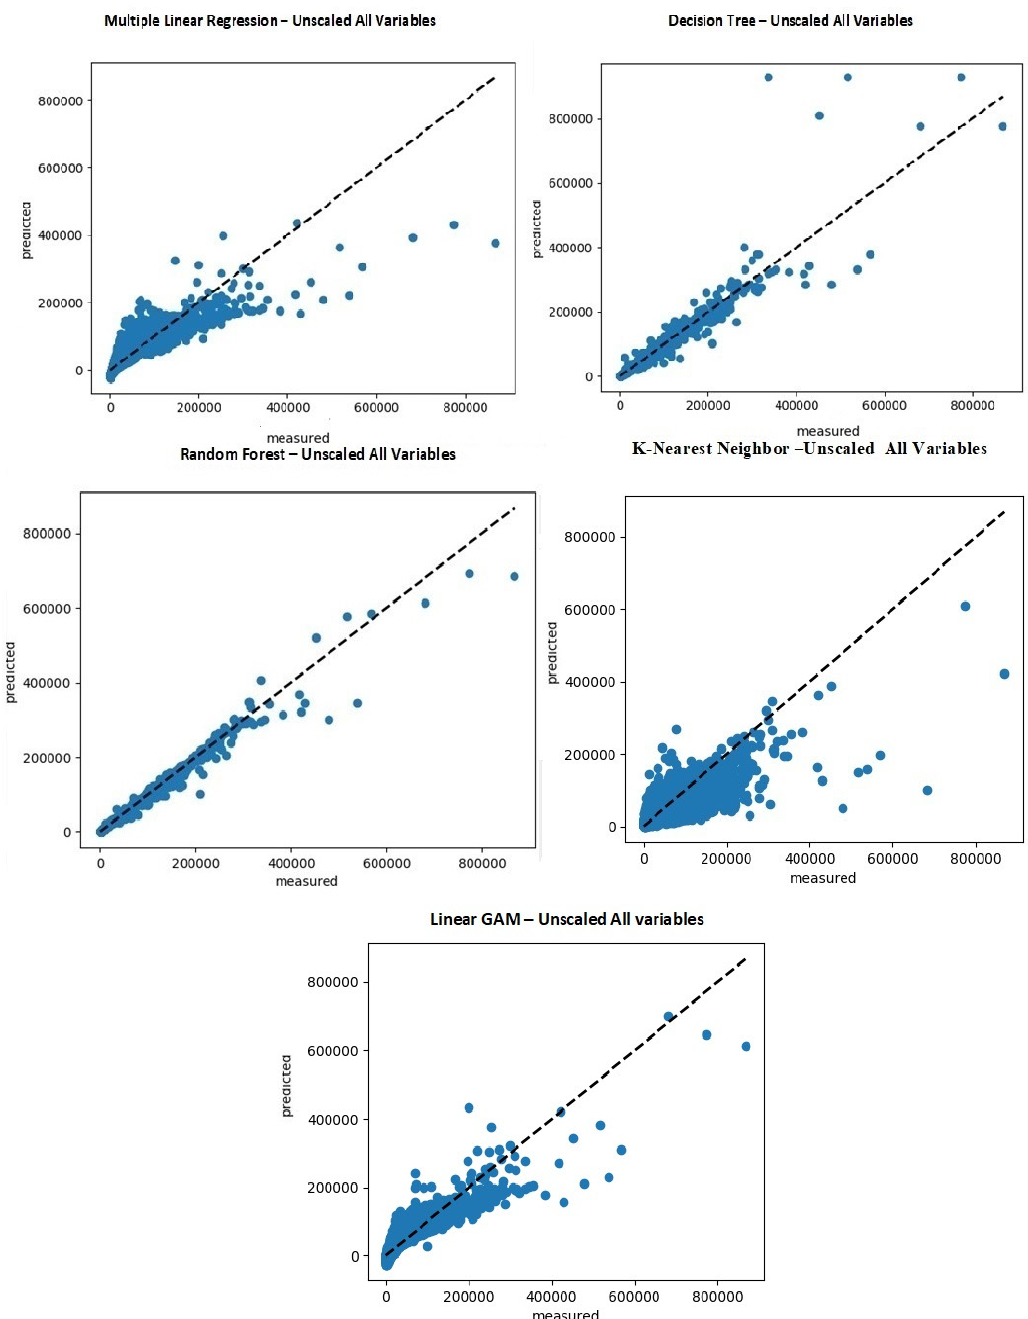
Figure 4. Performance of predicted vs. measured values for multiple linear regression, decision tree and random forest, K-nearest neighbors, and linear Generalized Additive Model for all variables for test dataset.